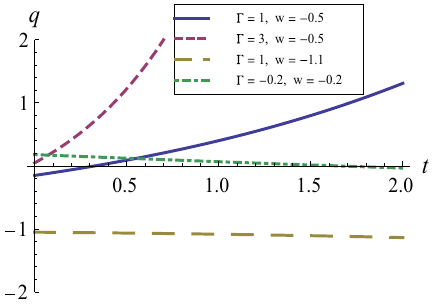
Fig. 1 The figure of deceleration parameter q against cosmic time t has been plotted for H 0 = 10